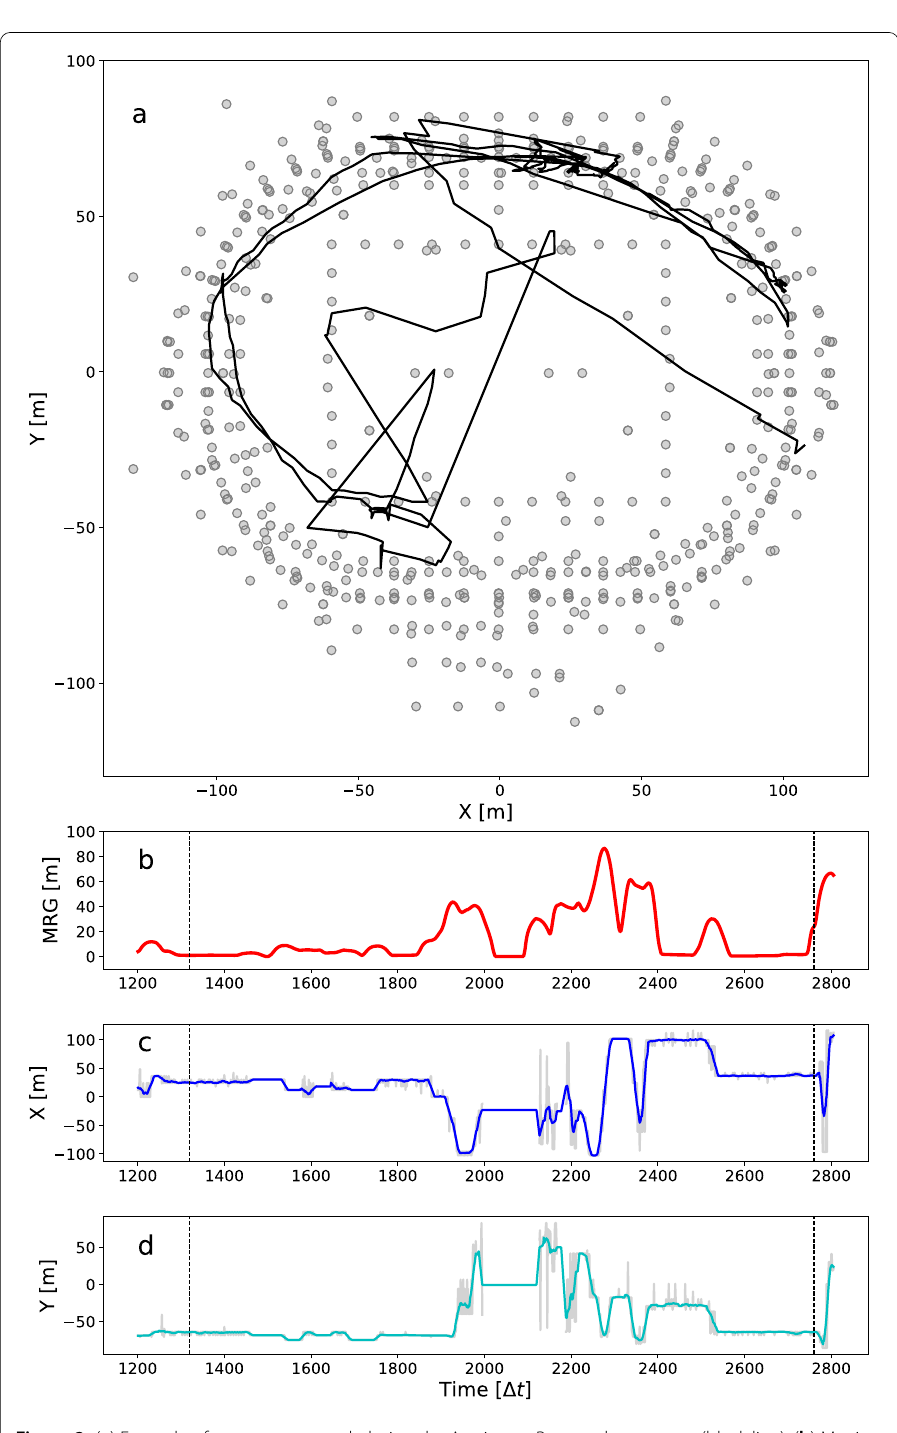
Figure 2 ( a ) Example of a movement track during the Armin van Buuren dance event (black line). ( b ) Moving radius of gyration (MRG) of the same movement track (red line) (unit = (cid:2) t = 10 s). ( c ), ( d ) Decomposition in x - and y -coordinate time series (blue and cyan lines), together with the original AP sequences produced by the proximity detection method (grey lines). The movement track starts at time bin 1201, which corresponds to 8:40 PM. Dotted vertical lines indicate start and end times of the DJ